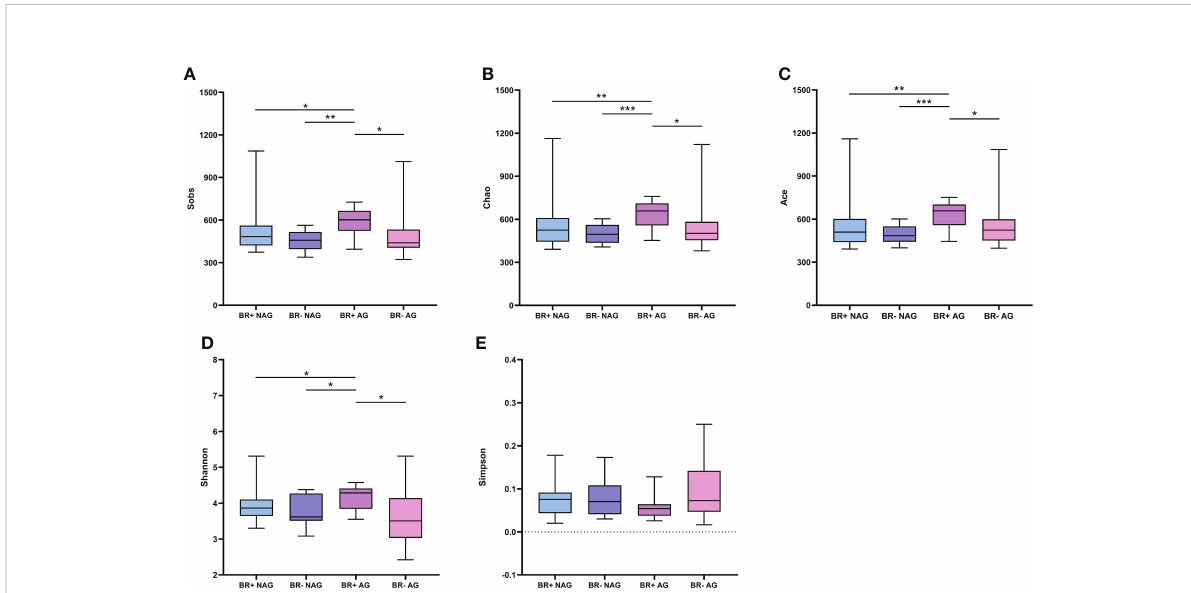
FIGURE 3 Alpha diversity of the gastric microbiota in the BR+ NAG, BR- NAG, BR+ AG, and BR- AG groups. The Wilcoxon rank-sum test was used to compare the Sobs (A) , Chao1 (B) , Ace (C) , Shannon (D) , and Simpson (E) indices between the groups. *, P < 0.05; **, P < 001; ***, P <